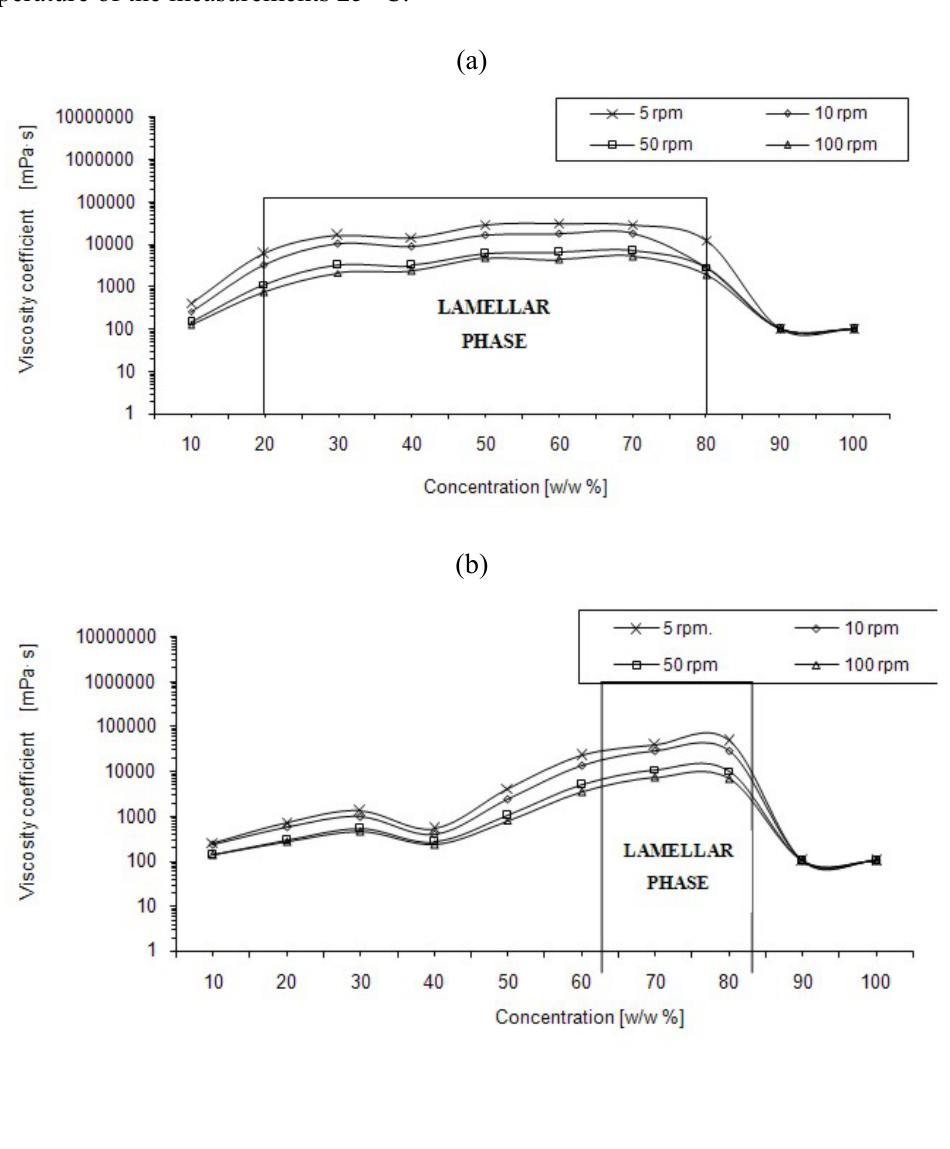
Figure 3. Dynamic viscosity coefficients ( η ) of aqueous solutions of four fatty alcohols ethoxylated with 3 (a), 5 (b), 7 (c) and 10 (d) moles of ethylene oxide. Brookfield HADV- III Ultra viscometer, Helipath spindles, rotational speed of spindles: 5, 10, 50, 100 rpm, temperature of the measurements 25